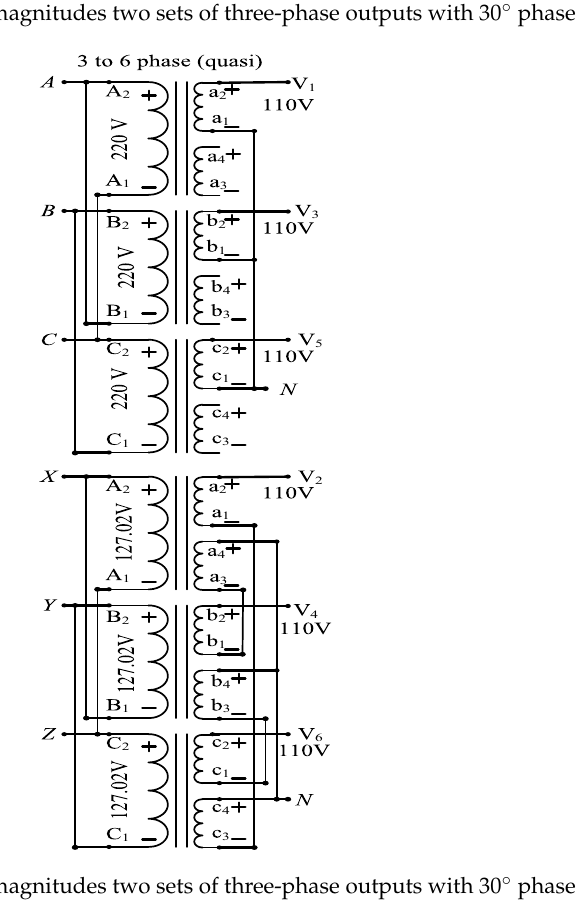
Figure 8. Obtaining equal magnitudes two sets of three-phase outputs with 30 ° phase shifts. Electronics 2019 , 8 , 109